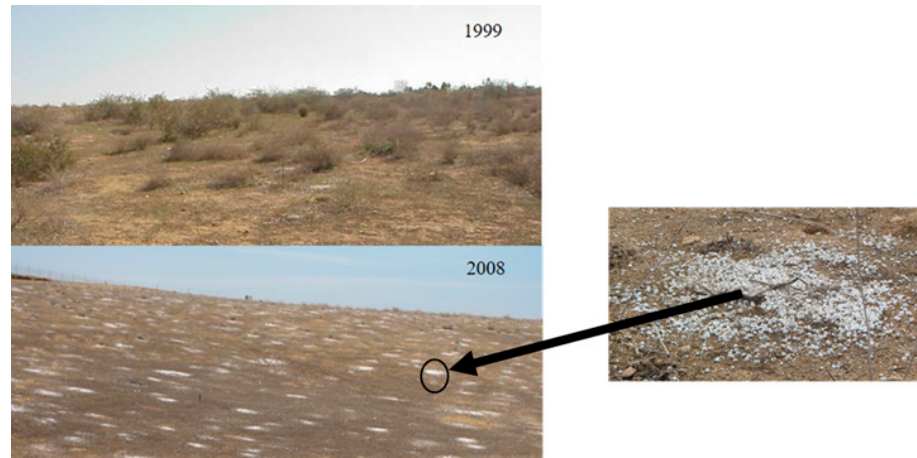
Figure 5. State transition in Park Shaked LTER site during the winter season, from functional state (shrub land) in 1999 into desertified state (crust land) in 2008. The shrubland ecosystem collapsed following years of drought in areas without runoff harvesting. The white spots are accumulations of dead snail shells under the canopies of dead shrubs (Source: Moshe Shachak and Shayli Dor— Haim).